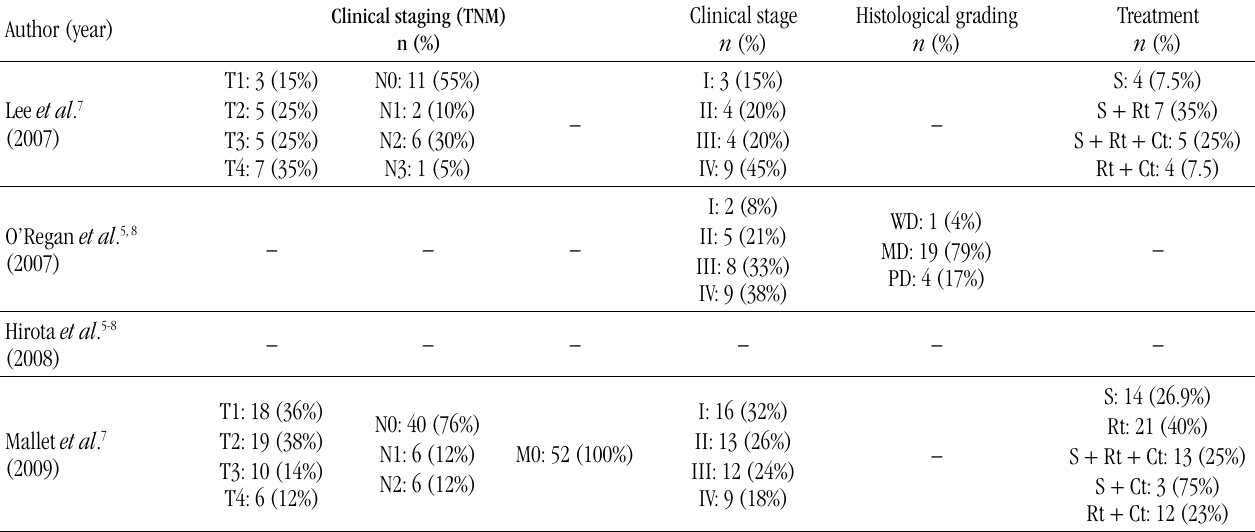
tABLE 3 – Descriptive distribution of the 17 studies on oral squamous cell carcinoma in young patients, selected from PubMed during 2007 and 2012, according to clinical, histopathological and therapeutic